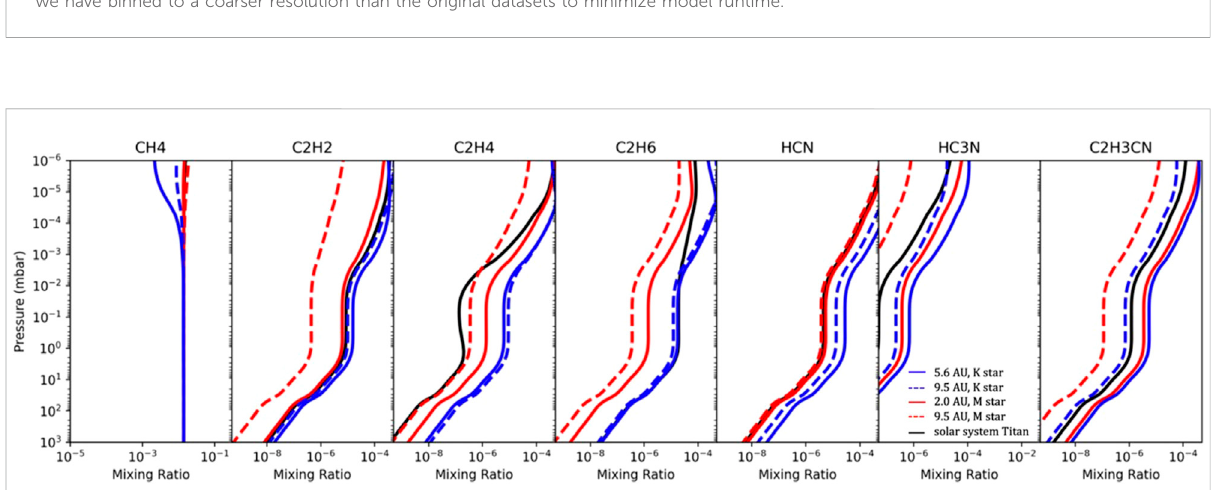
Stellar spectraoftheSun(black), an M4.5hoststar(red),andaKstar(blue), allshown at1 AU.Photon fl uxisshowninphotons/cm 2 /s. Weobtain theKandMstarspectrafromtheMUSCLESdatabase(Franceetal.,2016),andweadaptthesolar fl uxfromGladstoneetal.(2010).Inallcasesshown, we have binned to a coarser resolution than the original datasets to minimize model runtime.